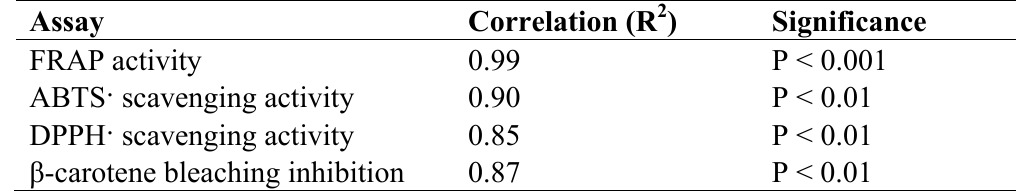
Table 4. Linear correlations between the amount of total phenolic content and antioxidant activities of ethanol extract and soluble fractions from Leptadenia pyrotechnica